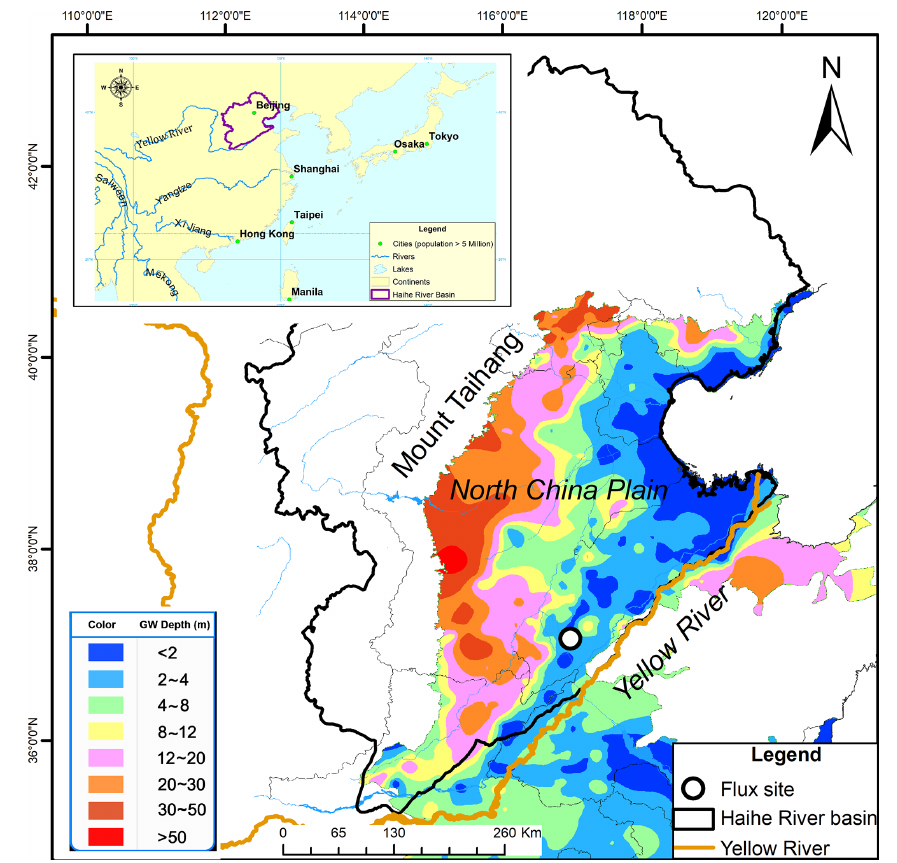
Figure 1. Location of the experimental site. The background is the shallow groundwater depth in early September of 2011 provided by the © Water Information Center in the Ministry of Water Resources, P.R.